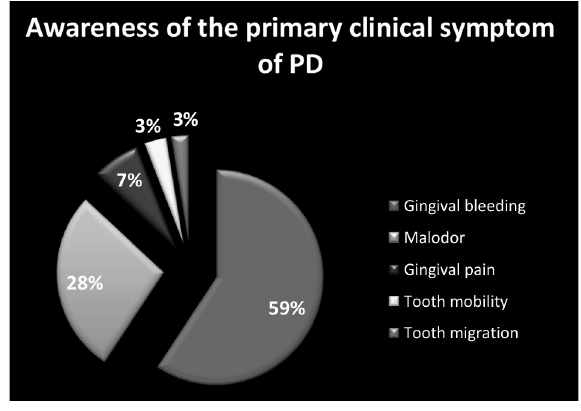
Figure 1. Awareness of the primary clinical symptom of